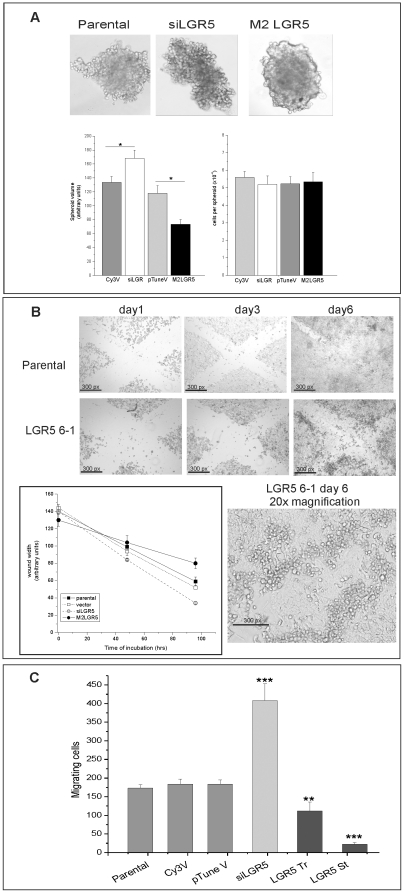
Effects of LGR5 modulation on cell-cell adhesion and migration.Lim1899 cells were transfected with vector controls (Cy3V and pTuneV), with Cy3- siLGR5 or with pTune/LGR5. Parental, transiently transfected cells (Tr) or stably transfected cell lines (St) were cultured under the following conditions: A) Cells were seeded in 30 µl droplets on a plastic surface, and the plate inverted to create hanging drops as described in Methods. Images were taken after 8 days by re-inverting the plastic support and imaging in bright field with a Nikon 90i microscope and a 10× lens. Digital images were acquired with a Photometrics CoolSnap digital camera. Spheroid volumes (left-hand graph) were calculated from these images using the modified ellipsoid formula. Spheroid sizes differed significantly between siLGR5 or M2LGR5 transfected cells and their counterparts transfected with empty vector (p = 0.0312 and p = 0.321, respectively, by the unpaired t-test). The cellularity of the spheroids (right hand graph) was assessed as described in Methods. In both graphs data represent the mean and standard deviation of 10 individual spheroids per cell line. B) Parental cells and cells stably transfected with pTune/LGR5 (clones 6-1) were plated at high density in 24-well plates. Wounds were scratched in the adherent monolyers and the wells were imaged every two days with a Nikon90i microscope using a 10× lens (upper panels). The photomicrograph on lower right shows a higher magnification of LGR5 6-1 wound at day 6 (20× lens). Insert: Rate of wound closure over 96 hr. C) Cells were seeded in Transwell inserts (8 mm pore size) and cultured for 4 days. Filters were fixed and stained with May-Grumwald/Giemsa. Cells on the upper side of the filters were removed, and filters mounted on glass slides. Cells present on the underside of the filters (migrating cells) were counted by light microscopy as described in Methods. The graph presents average and sd of three separate samples for each cell type. Tr and St denote transient and stable LGR5 transfectants. Significance levels were determined by the unpaired t-test. *** = p<0.001; ** = p<0.005.